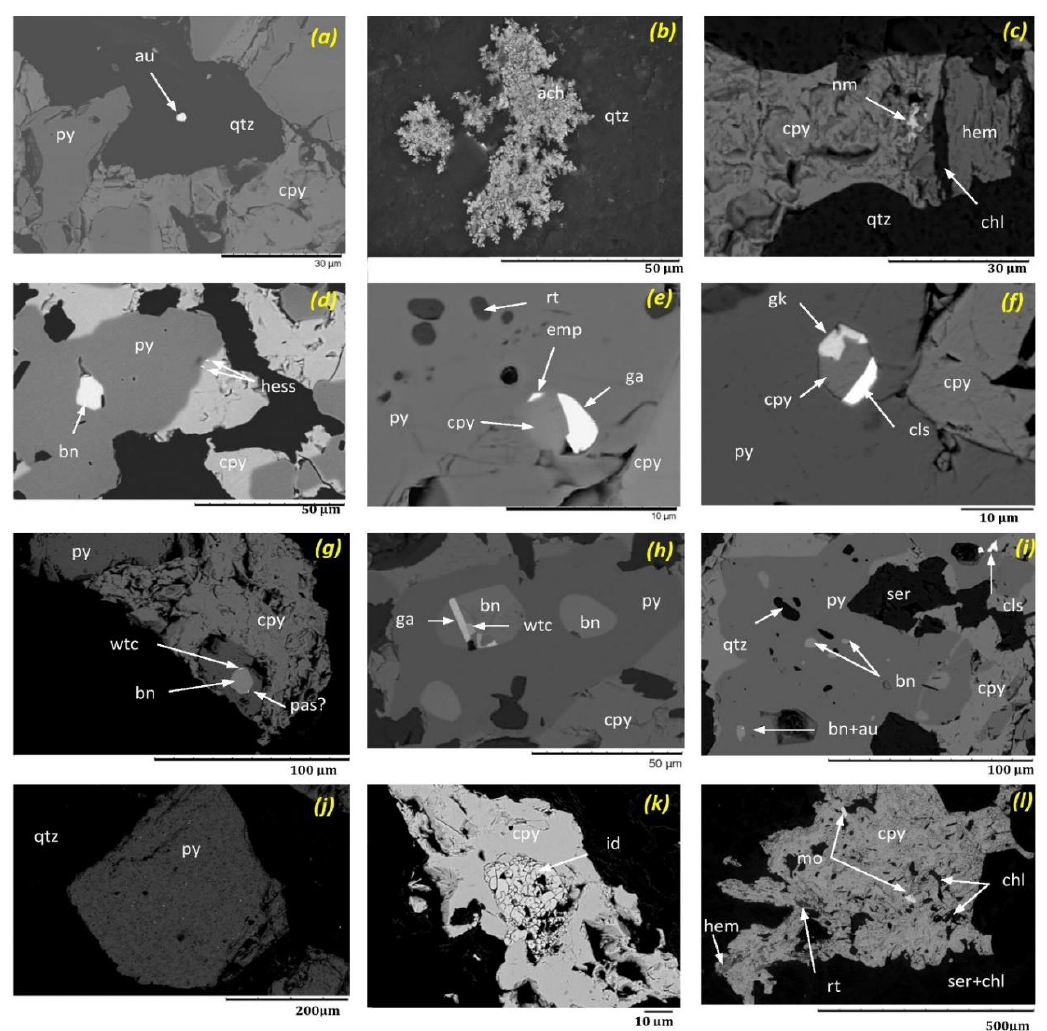
Figure 6. Back-scattered electron images of trace minerals from Assarel copper deposit. ( a ) Gold in quartz (CPH assemblage, sample AS18) ( b ) dendritic acanthite in QP assemblage (sample AS2); ( c ) naumannite in chalcopyrite in association with hematite and chlorite (CPH assemblage, sample AS21); ( d ) hessite occurring at the limit between pyrite and chalcopyrite (CPH assemblage, sample AS18); ( e – h ) polymineral inclusions hosted by pyrite in CPH assemblage (sample AS18); ( i ) chalcopyrite and pyrite mineralization from CPH assemblage with bornite, gold and quartz inclusions in pyrite and clausthalite grains at the margin of chalcopyrite (sample AS18); ( j ) numerous bismuthinite inclusions (white dots) in euhedral pyrite from QP assemblage (sample AS2); ( k ) idaite on chalcopyrite (CPM assemblage, sample AS6); ( l ) molybdenite and chlorite crystals in chalcopyrite in association with